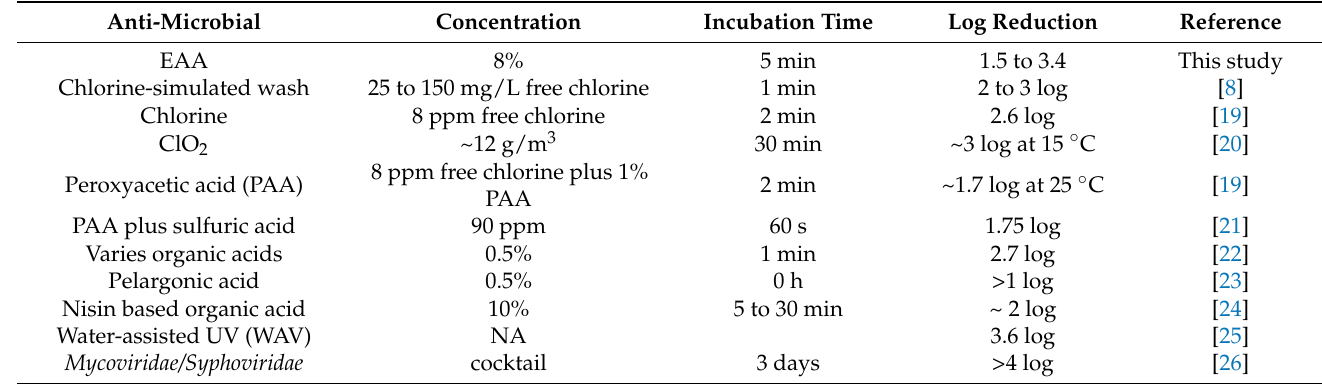
Table 1. Examples of currently used anti-microbials to reduce S. enterica on